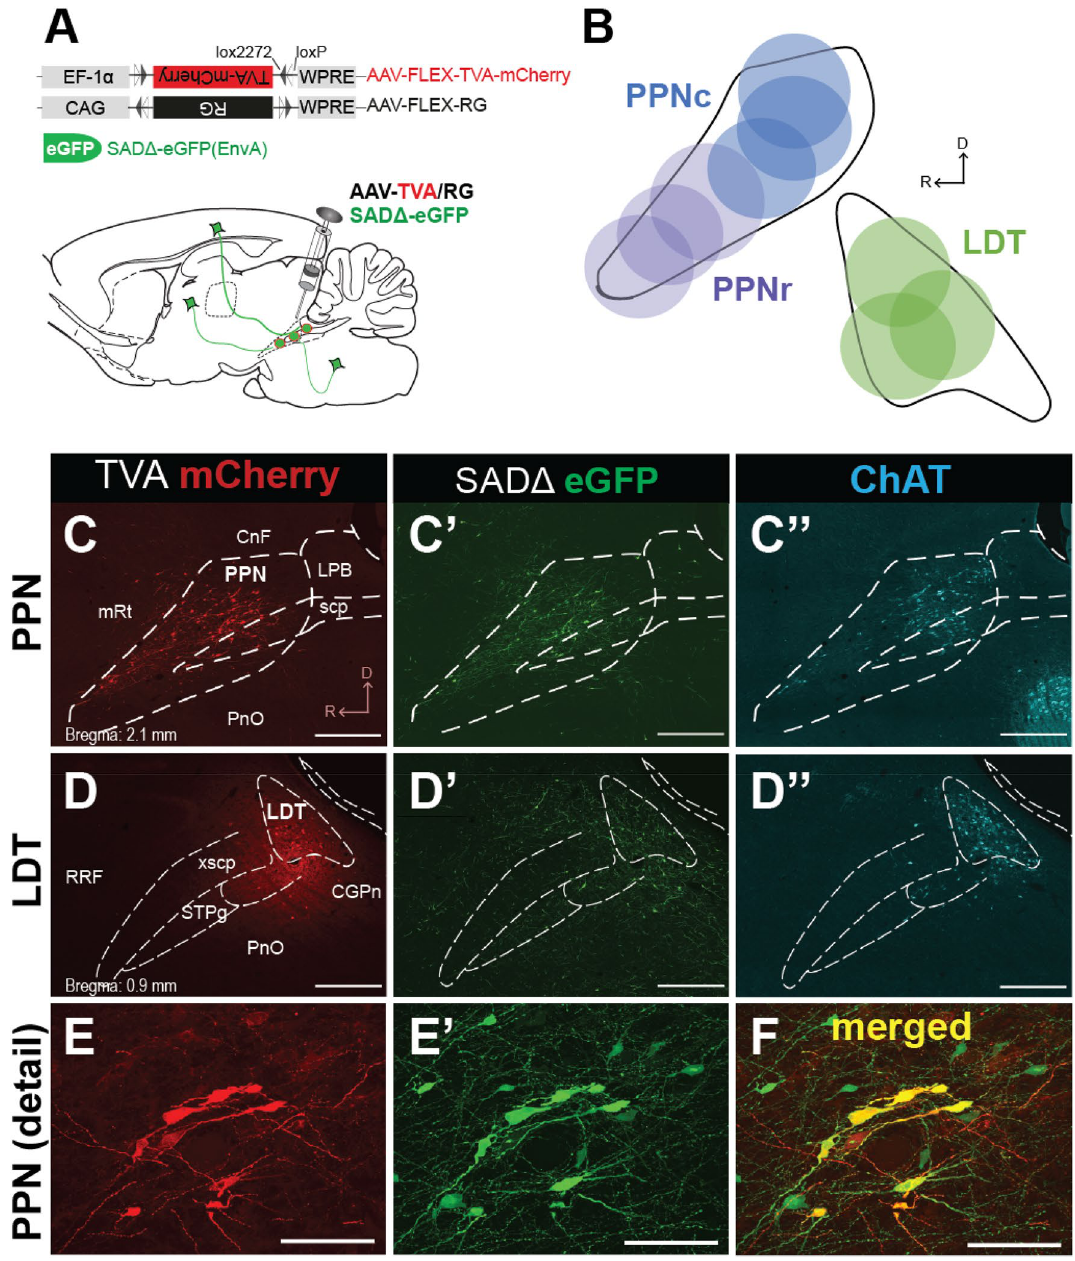
Figure 1. Transsynaptic retrograde tracing of midbrain cholinergic neurons. ( A )Schematic of the experimental procedure. AAV5-FLEX-TVA-mCherry and AAV8-FLEX-RG helper viruses were injected into the PPN or LDT of rats that expressed Cre in cholinergic neurons. Two weeks after these injections, a modified rabies virus SADΔG-eGFP (EnvA) was injected into the same area and the brain was processed after 7 days. ( B ) Location of the site of injections in the PPN and LDT. ( C–E ) Injections were confined to the borders of the PPN ( C–C ′ ) and LDT ( D–D ′ ), as determined by ChAT immunolabeling in parasagittal sections ( C ″ and D ″ ). E, Starter neurons were identified by the expression of the TVA helper reporter and SADΔ-eGFP. Scale bars ( C ) and ( D ): 1 mm. ( E – F ): 100 described in the Methods (total: 50 structures; Fig. 3). The average total number of input neurons was 1508 ± 428 for the PPN and 874 ± 115 for the LDT. Analysis of the proportional contribution of each structure relative to the overall total number of input neurons to the PPN and the LDT for each animal revealed that several struc- tures in the midbrain and the basal ganglia preferentially innervate the PPN. We observed that the vast majority of inputs to PPN cholinergic neurons originated in SC (10.24% ± 2.45, 356 ± 86 average number of neurons). Within the SC, input neurons were preferentially located in the deep gray layer (DpG, 38.5% ± 4.6) but neurons also distributed notably in the deep (DpWh, 23.12% ± 3.44) and intermediate white layers (InWh, 18.82% ± 4.5)